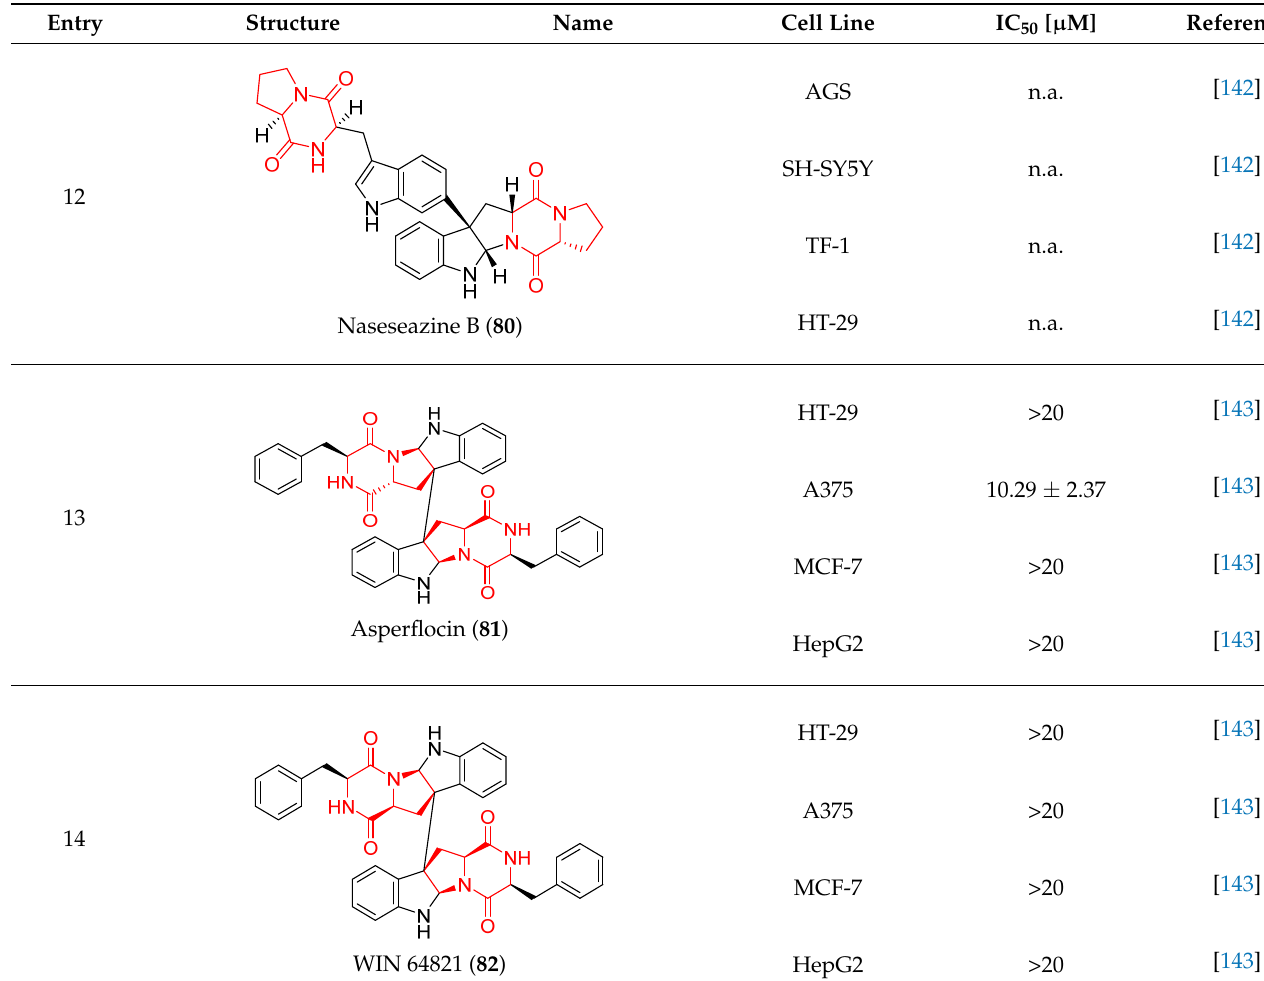
The more potent Waikikiamide A ( 76 ) exhibited activity with IC 50 [ μ M] values from 0.519 (HT1080) to 1.855 (PC3) (Table 5, entry 8), while Waikikiamide B ( 77 ) from 1.127 (A2780S) to 1.805 (PC3) (Table 5, entry 9). Dimeric Stephacidin B ( 78 ) was isolated together with Stephacidin A ( 70 ) from Aspergillus ochraceus WC76466 strain [136] and tested on a similar panel of ten cancer and one reference non ‐ cancerous cell lines: PC3, LNCaP, A2780, A2780/DDP, A2780/Tax, HCT116, HCT116/mdr+, HCT116/topo, MCF ‐ 7, SKBR3 and LX ‐ 1. Compound 78 exhibited stronger cytotoxic effect then compound 70 with IC 50 [ μ M] values varied from 0.06 (LNCaP) to 0.46 (HCT116, HCT116/mdr+) (Table 5, entry 10). Nandaseseazine A ( 79 ) Naseseazine B ( 80 ) were obtained from Streptomyces sp. (CMB ‐ MQ030) isolated from a Fijian marine sediment and tested for cytotoxicity on four cancer cell lines: AGS (gastric adenocarcinoma), SH ‐ SY5Y (neuroblastoma), TF ‐ 1 (erythroleukemia) and HT ‐ 29 (colorectal adenocarcinoma) but were found to be rather